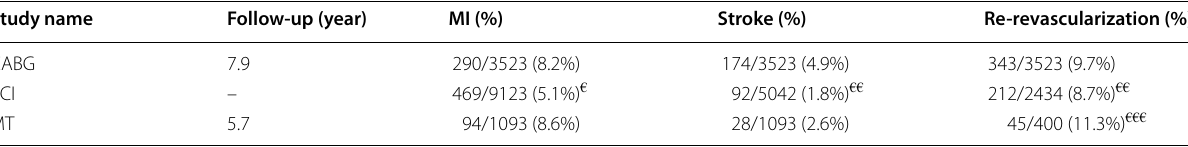
€ : after 4.7 years of follow-up; €€ : after 8.4 years of follow-up; €€€ : after 6.8 years of follow-up; PCI: percutaneous coronary intervention; CABG: coronary artery bypass graft; MT: medical